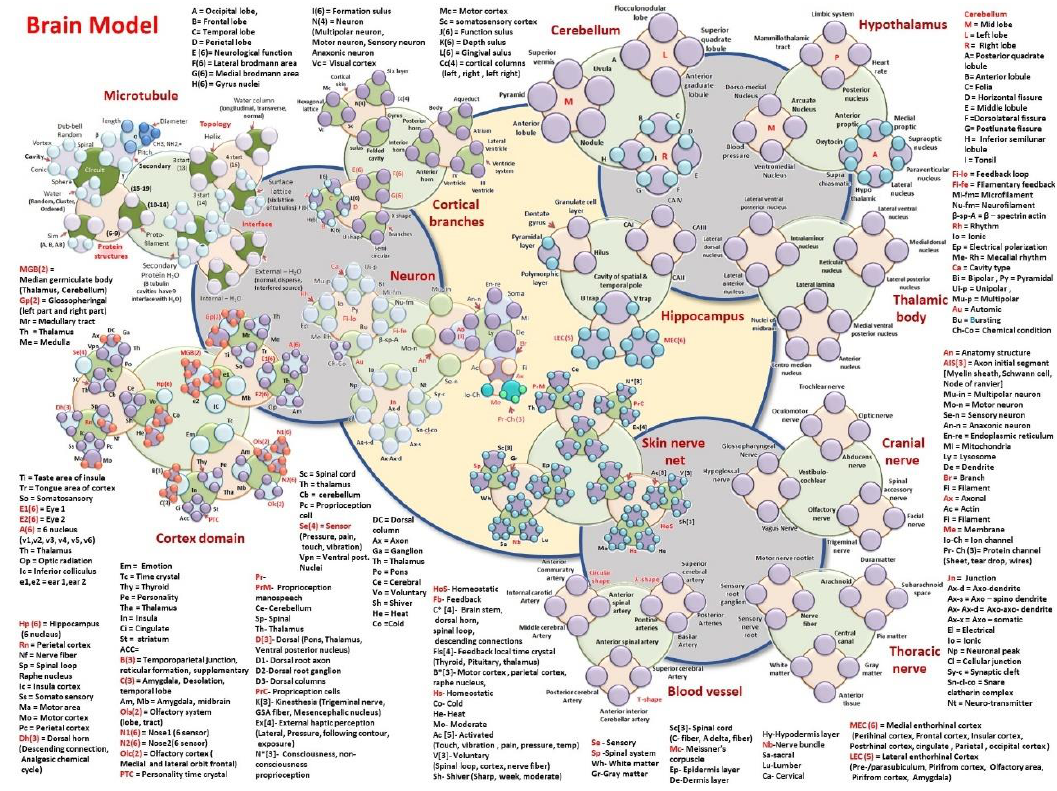
Figure 15. 2D time crystal model for the whole brain [41].